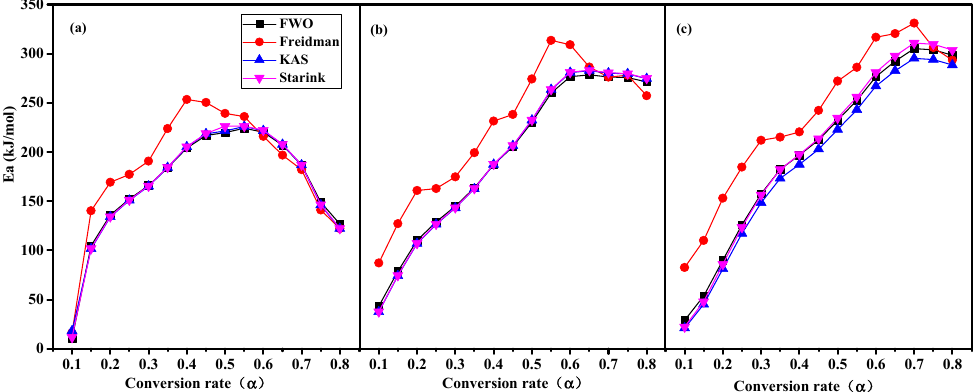
Figure 3. Variation in activation energy from different isoconversional model-free methods of RS ( a ), ATB ( b ), and PS ( c ).